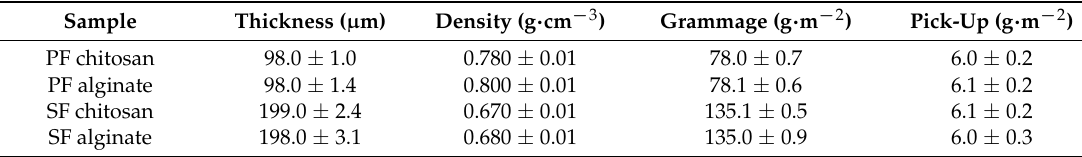
Table 3. Thickness, density, grammage, and pick-up values of alginate- and chitosan-coated primary-fiber (PF) and secondary-fiber (SF) samples ( n =